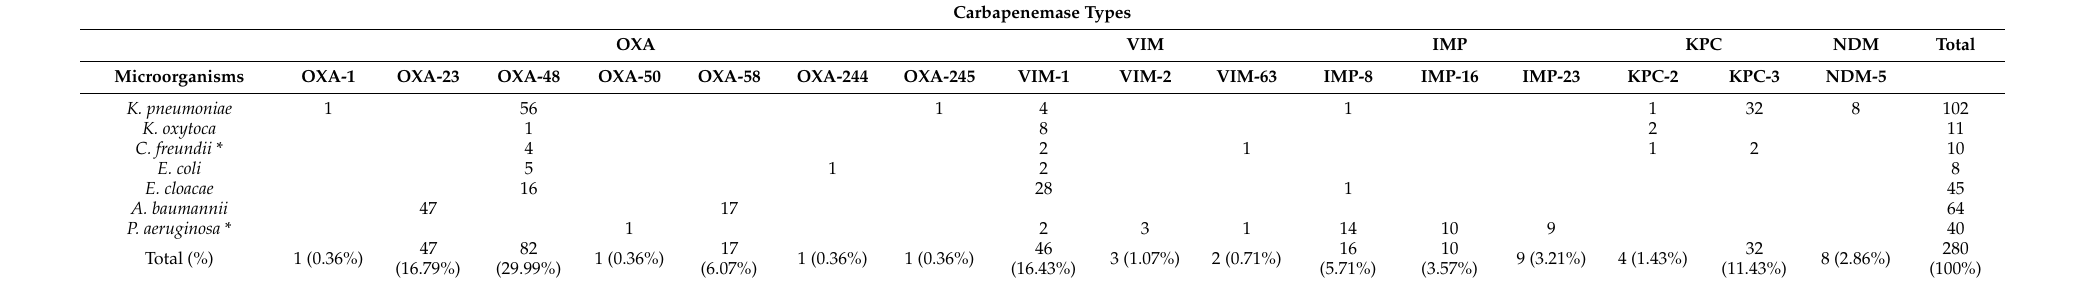
Table 2. Subgroups of carbapenemases detected in each carbapenemase-producing bacteria (CPB).